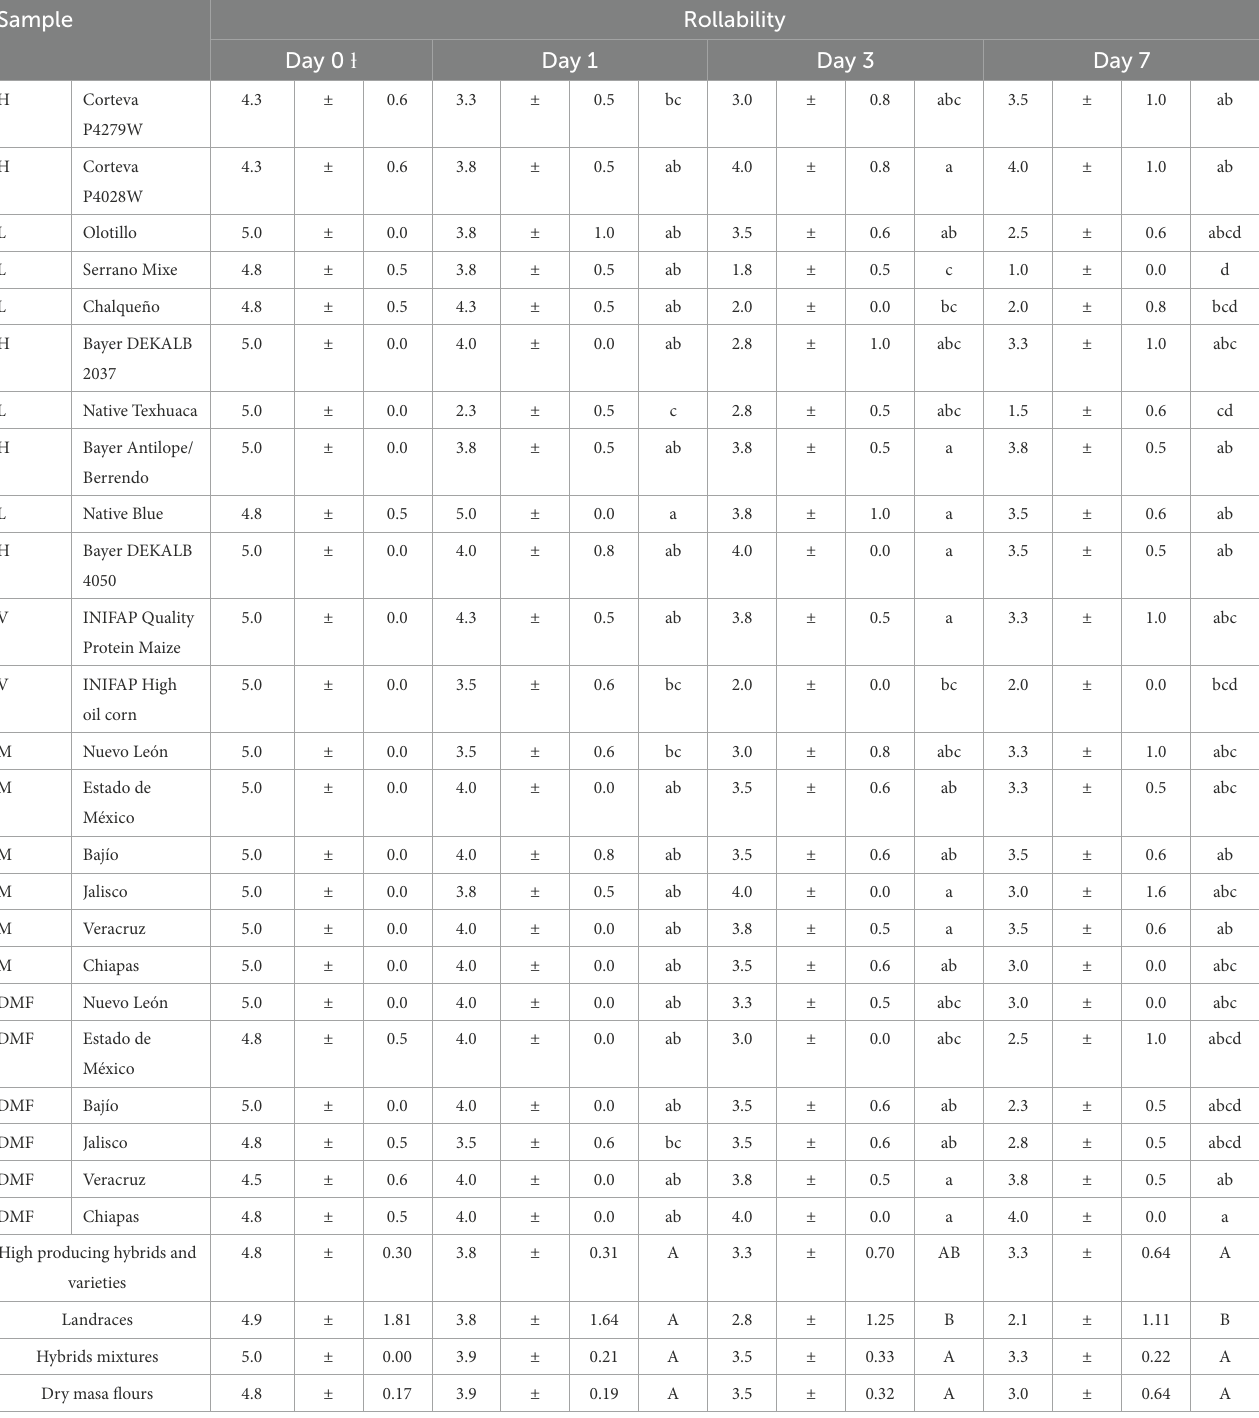
TABLE 7 Rollability of tortillas evaluated through a week old.